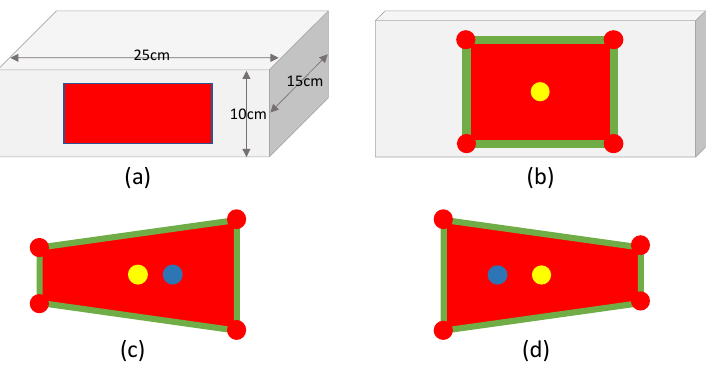
Figure 2. Schematic of the transportation object where ( a ) is a transportation object, and the view of the robot in ( b ) the center of box, ( c ) the right of box, ( d ) the left of box.